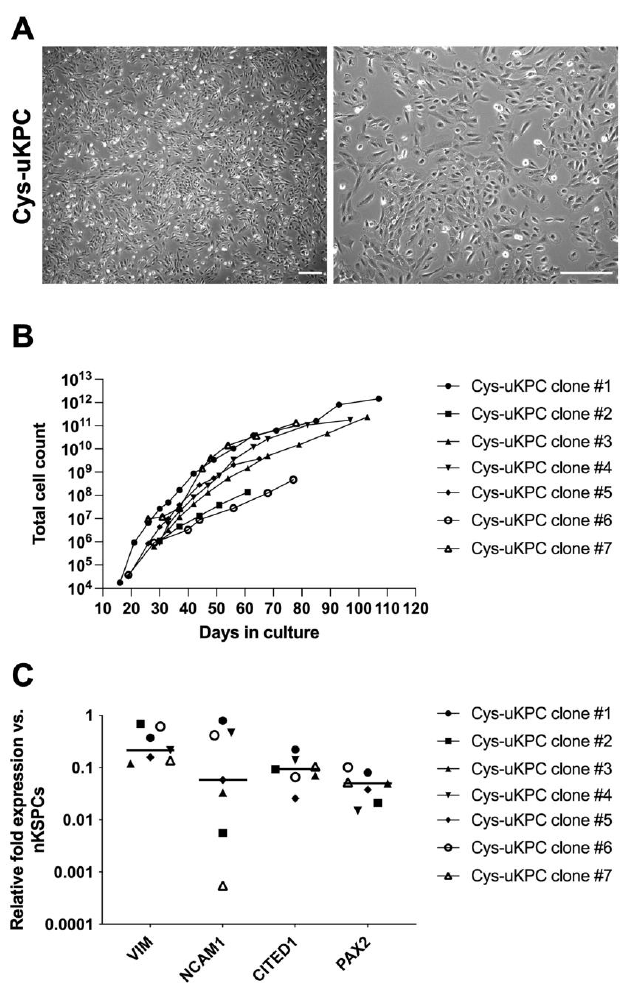
Figure 2. Characterization of cystinosis urine-derived kidney progenitor cell (Cys-uKPC) clones. ( A ) Phase contrast microscopy of a representative clone of Cys-uKPCs (Cys-uKPC #1) shows the characteristic petal-like pattern of in vitro expansion and organization (left panel) and the spindle- shaped to rhombic cellular morphology (right panel). Scale bar: 250 μ m; ( B ) In vitro proliferative capacity of the seven established Cys-uKPC clones. Total number of cells grown versus days in culture before Cys-uKPC clones showed senescence and stopped proliferating. Each specific Cys-uKPC clone is represented by a symbol that is similarly used in panel ( B , C ) (see the legend on right in the figure). ( C ) Relative fold expression of a panel of selected nephrogenesis genes for characterizing the Cys-uKPC clones ( n = 7), relative to β -actin and normalized to the expression in human neonatal kidney stem/progenitor cells (nKSPCs). In the midst of the individual values, the median of the values is represented by the horizontal line.